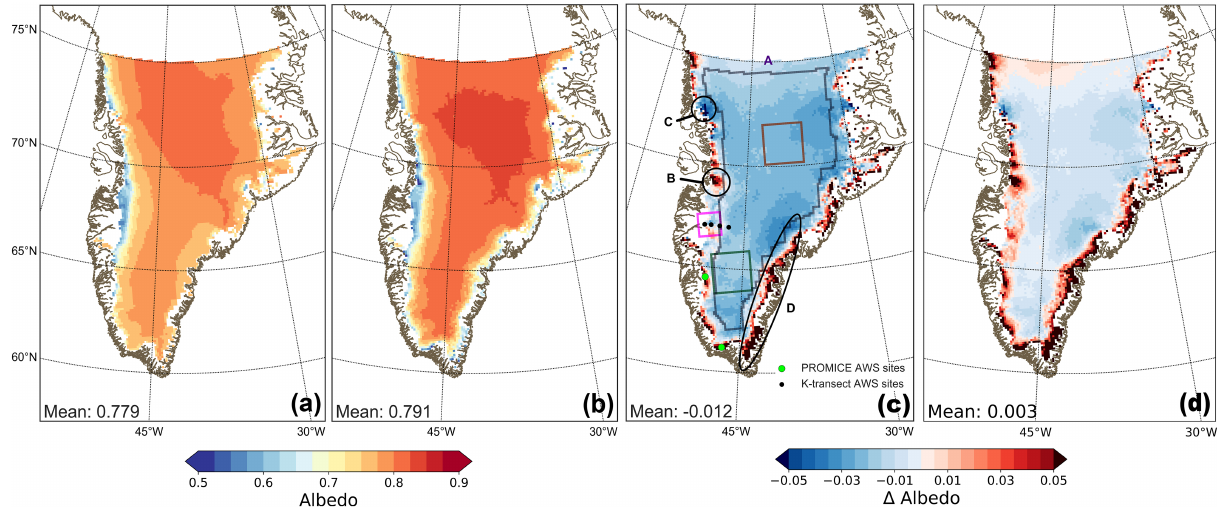
Figure 2. (a) Average 16d running mean clear-sky RACMO2.3p3 albedo for 15:00UTC (12:00LT for most of Greenland) between 2006 and 2015, (b) MODIS MCD43A3 clear-sky diffuse (CSD) albedo, (c) albedo difference between RACMO2.3p3 clear-sky albedo and MODIS MCD43A3 CSD albedo and (d) like (c) but now after applying a uniform − 0.015 bias correction to the MODIS MCD43A3 data. AWS locations of the K-transect are indicated in (c) by the black dots, from west to east: S5, S6, S9 and S10. PROMICE AWS NUK-U (north) and QAS-U (south) are indicated by the light-green dots. KAN-U and KAN-M are located close to S10 and between S6 and S9, respectively, but are not shown separately. Extended evaluation is done for the enclosed purple region that is indicated by A; for areas B, C and D; and for the regions enclosed in the colored